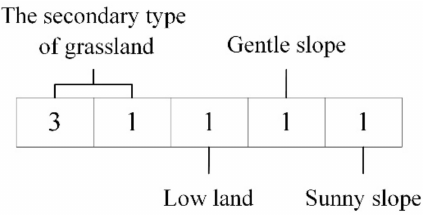
Figure 4. An example of how the sample selection range was recoded.